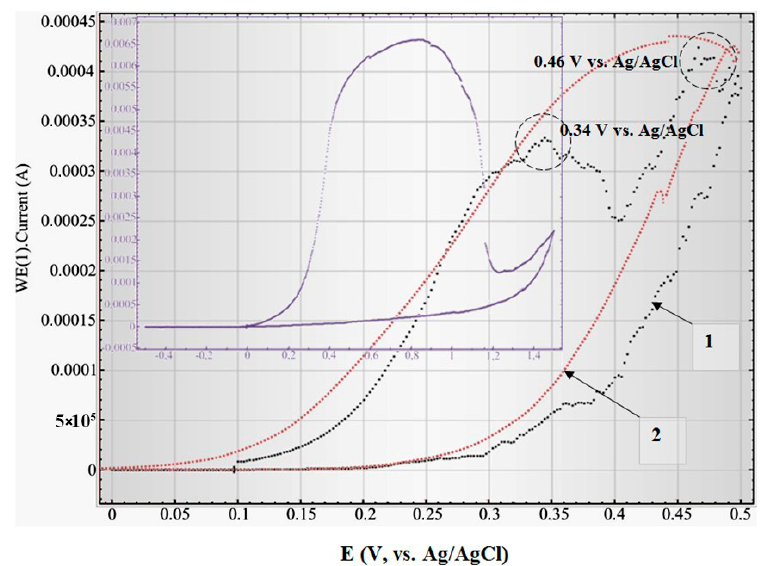
Figure 10. Influence of a scan rate of potential on electrochemical behavior (and cyclic polarization curve) of the Ti/PAAT/Ni electrode: 1—at a potential scanning rate 0.01 V/s (the first cycle). 2—at a potential scanning rate of 0.03 V/s (the first cycle). In the insert—at a scan rate of potential 0.1 V/s (the first cycle).